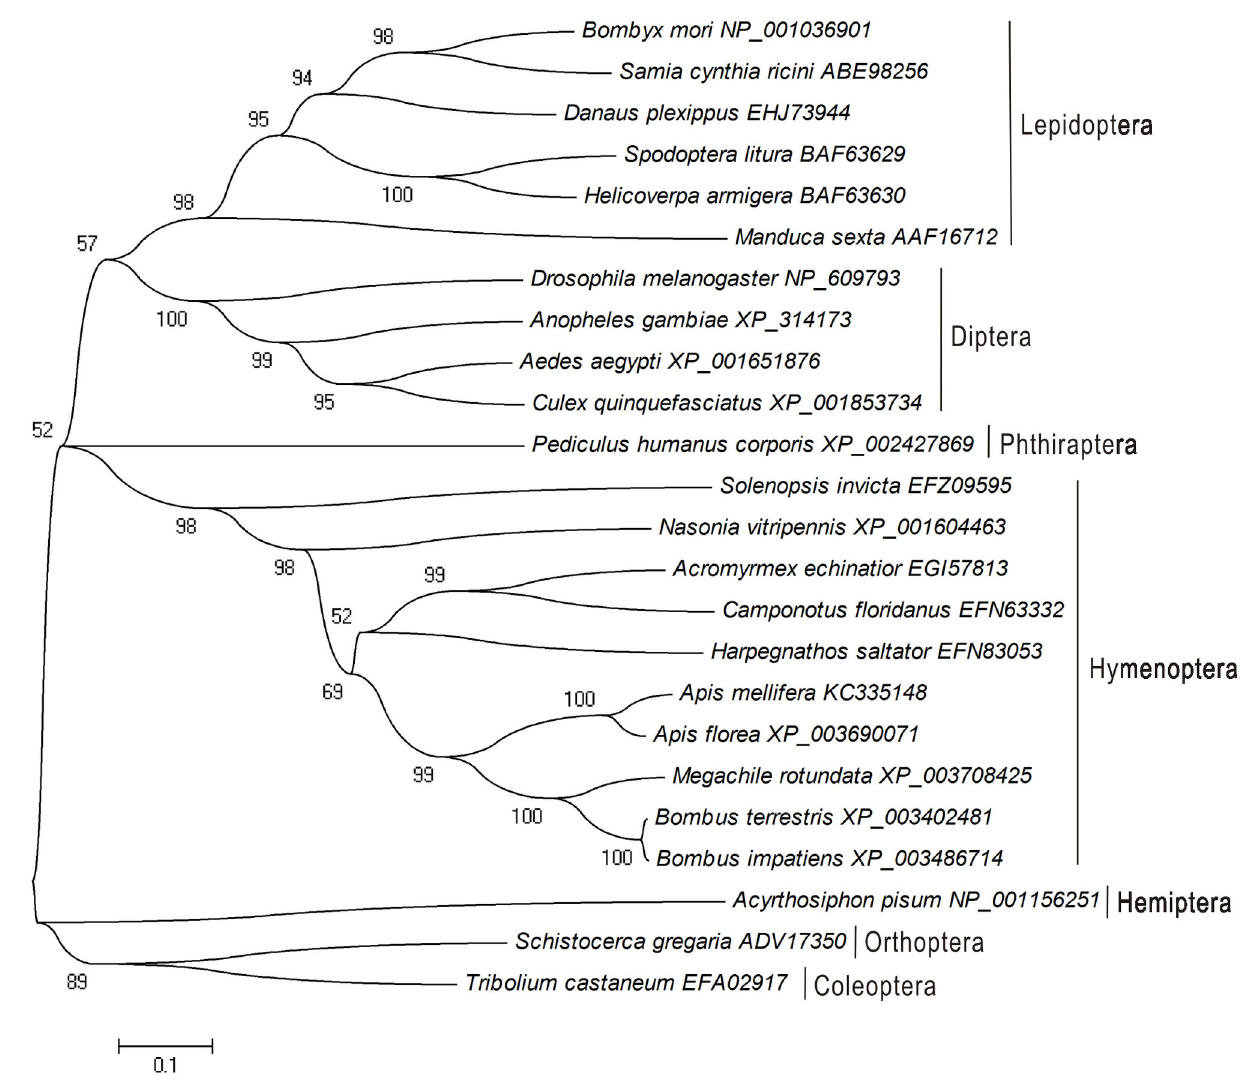
Figure 2. Phylogenetic analysis of JHAMT homologs from different insect species based on amino acid sequences. Sequences are labeled with the species Latin names plus GenBank accession numbers. Bootstrap values (1000 replicates) are displayed by the nodes. The genetic distance is drawn to